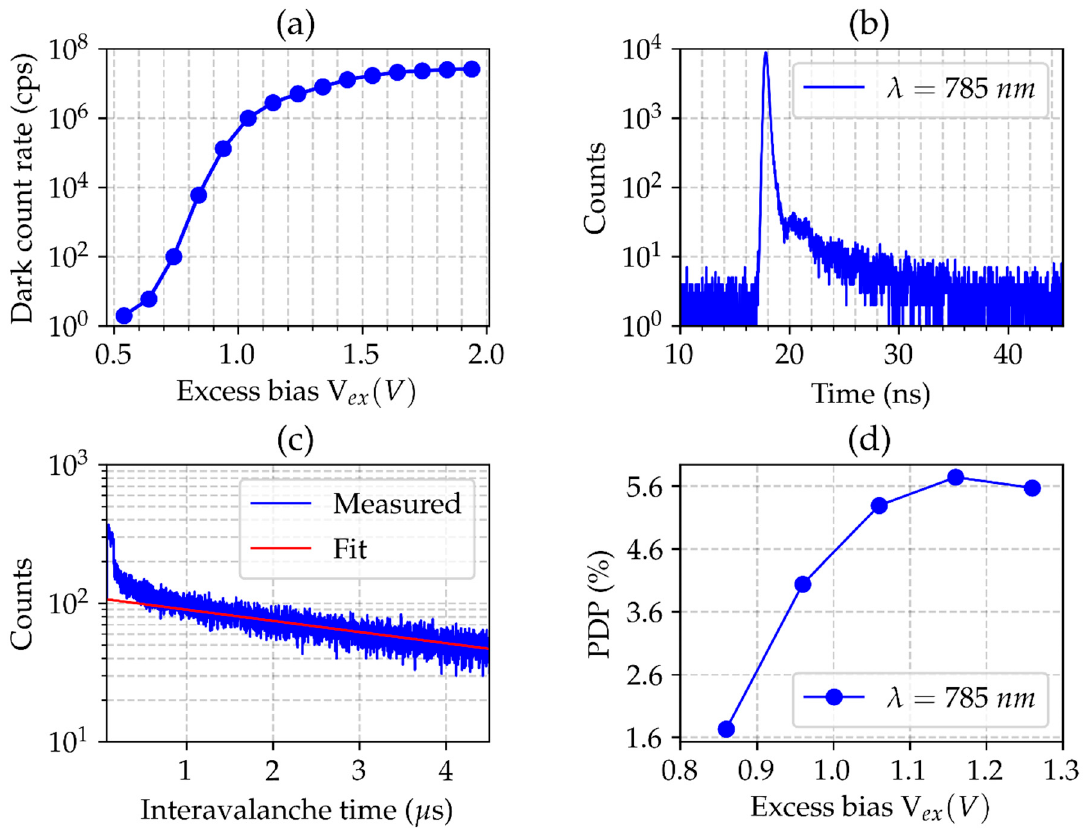
Figure 5. ( a ) Measured dark count rate with respect to the excess bias voltage. ( b ) Timing jitter full-width half-maximum (FWHM) = 370 ps (V ex = 0.86 V). ( c ) Measured interavalanche times to characterize afterpulsing (V ex = 0.86 V) with an exponential fit ( d ) Measured photon detection probability with respect to the excess bias voltage at a wavelength of 785 nm.